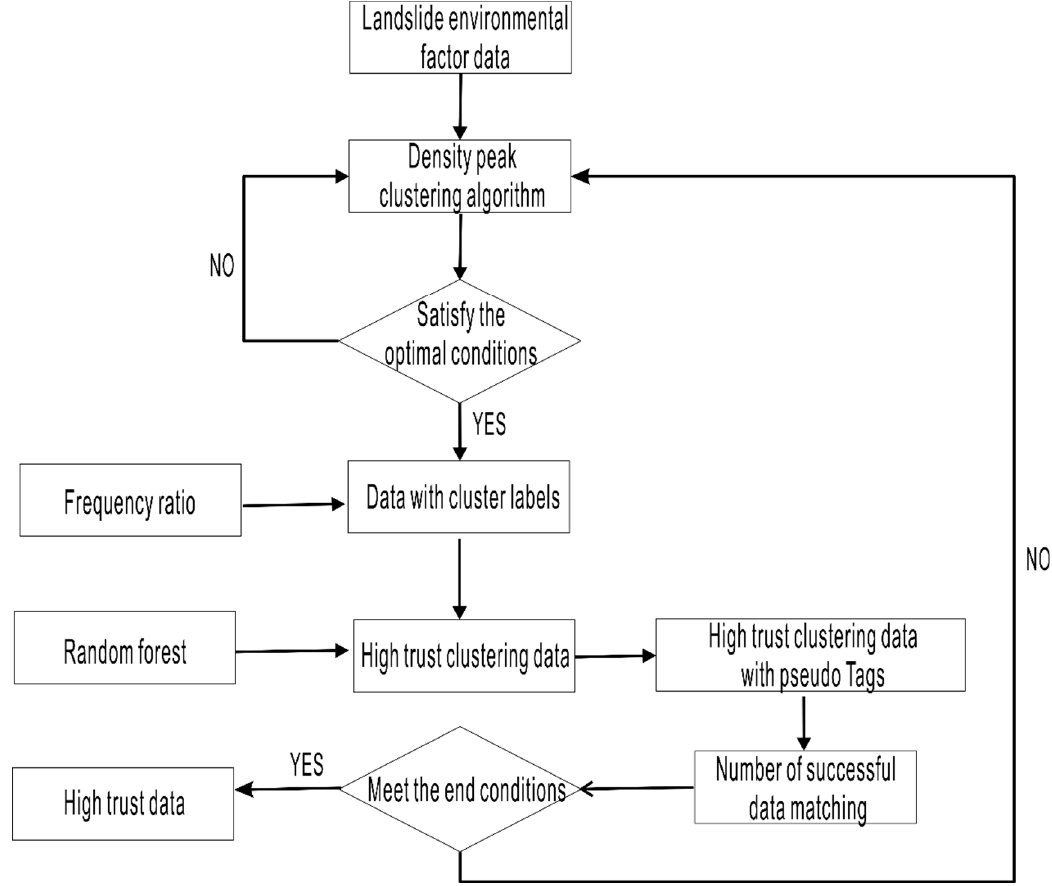
Figure 4. Flowchart of the semi-supervised learning framework.